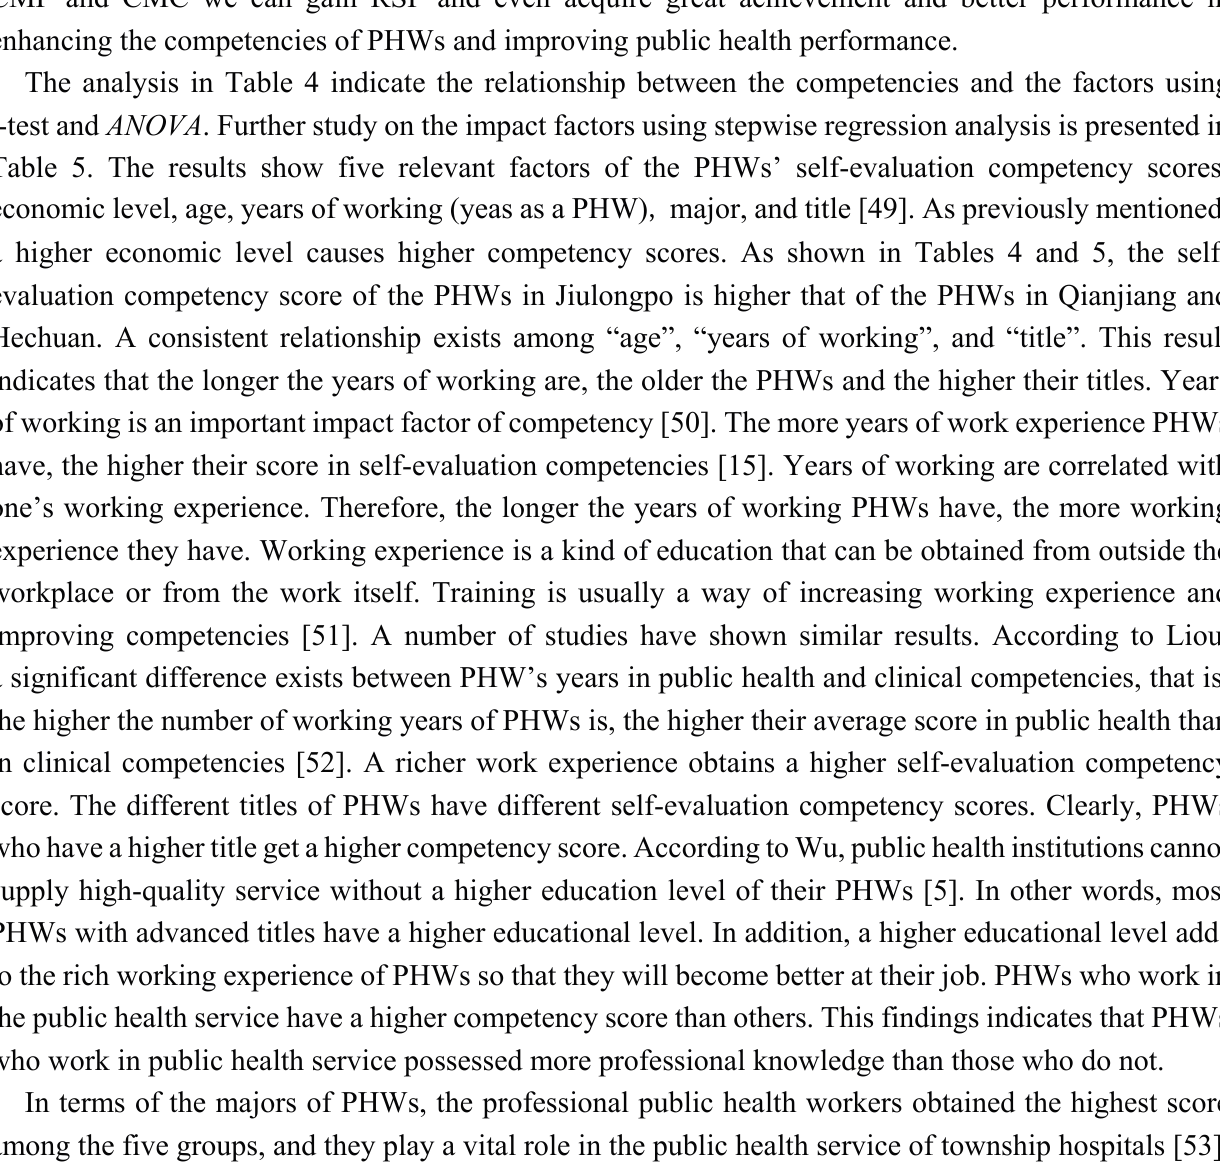
Table 5. The results show five relevant factors of the PHWs’ self-evaluation competency scores: economic level, age, years of working (yeas as a PHW) , major, and title [49]. As previously